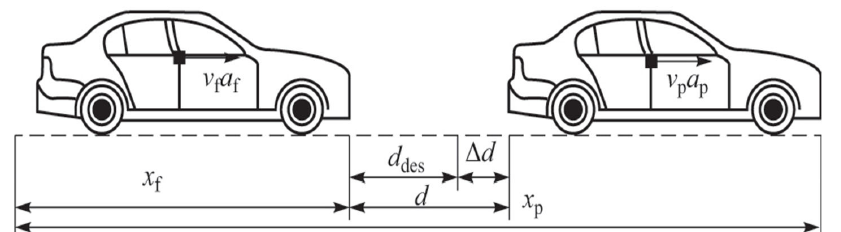
Figure 1. Longitudinal kinematics model of adaptive cruise.